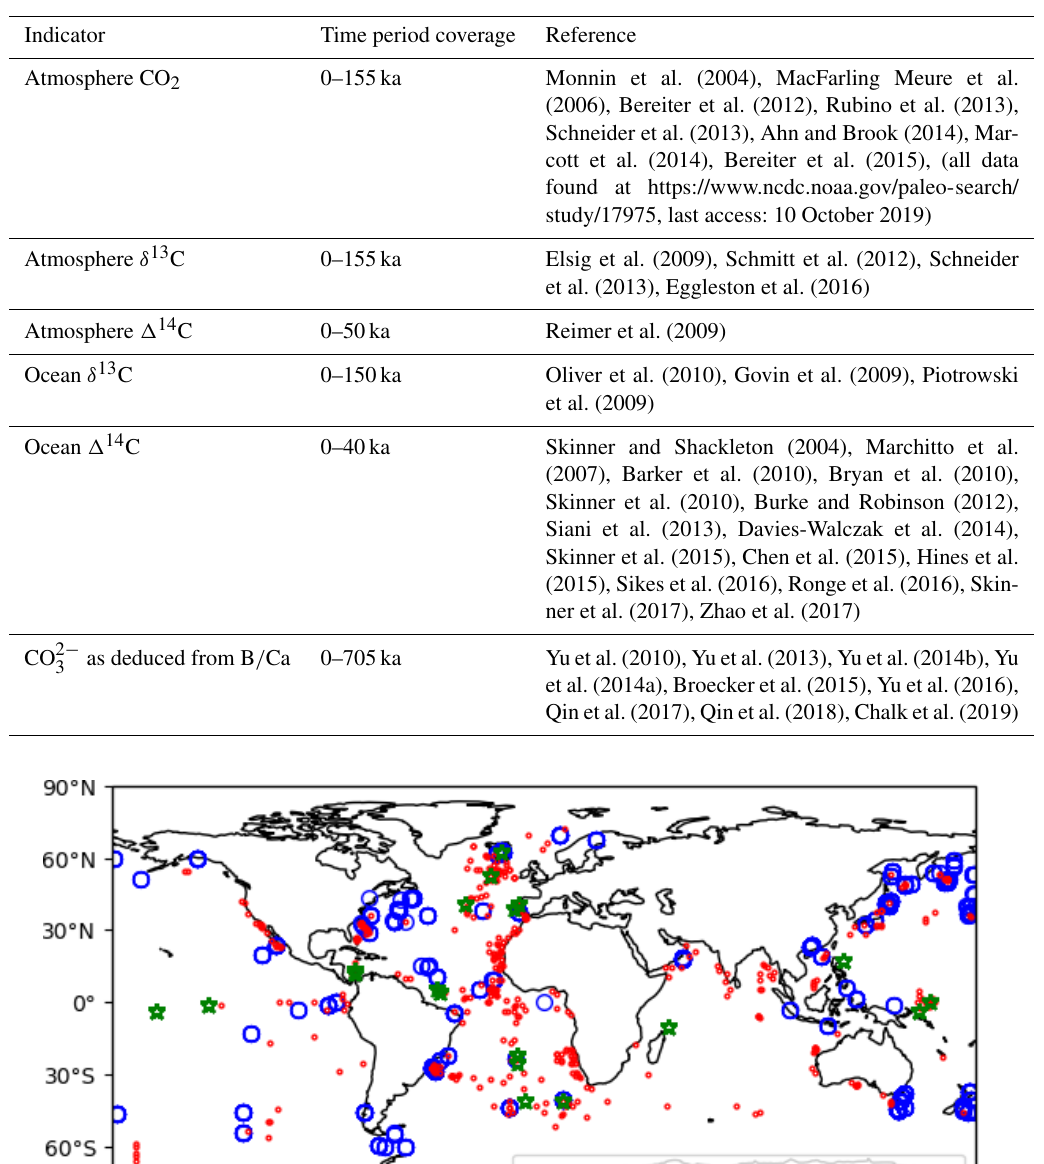
Table 2. Ocean and atmosphere proxy data sources for the last glacial–interglacial cycle